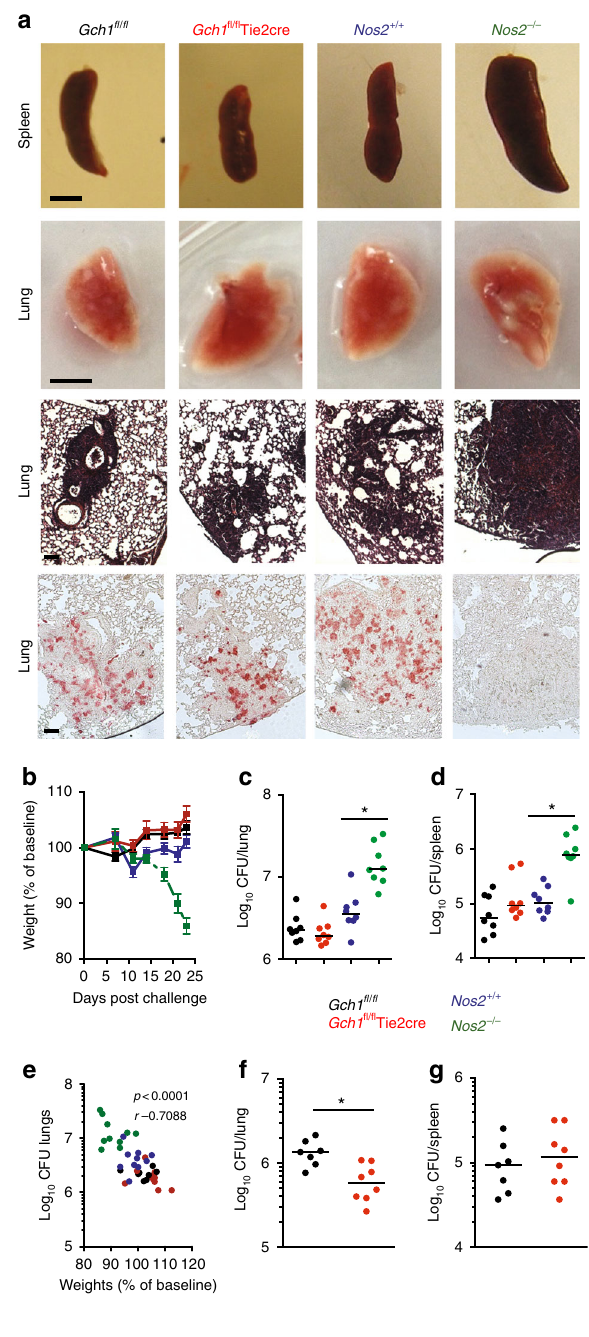
Fig. 3 Absence of Gch1 increases resistance of mice to virulent M.tb infection. Gch1 fl / fl Tie2cre (red) and wildtype (black), Nos2 − / − (green) and Nos2 + / + (blue) mice were infected with 150 CFU M.tb (Erdman strain) by aerosol inhalation. 23 days following infection the lungs and spleen were removed for analysis. Representative organs were imaged from each genotype prior to n = 2 tissues per genotype being embedded for histochemical analysis. Sections were cut from all tissues and stained with H&E or subjected to anti-iNOS immunohistochemistry ( a ). Animals were weighed at regular intervals throughout the experiment and the mean weight change and SEM per group was plotted ( b ). Lungs and spleen were homogenised and the mycobacterial load of the organs was enumerated by CFU count from lung ( c ) and spleen ( d ) ( n = 8 per group, * p < 0.01) (Mann – Whitney). Each dot represents one mouse, line in each group represents the median CFU. e Weights negatively correlated with CFU counts. Pearson r p < 0.05. f Gch1 fl / fl Tie2cre (red) and Gch1 fl / fl (black) mice were infected as before but this time lungs and spleen were removed 6 weeks following infection for analysis. Lungs and spleen were homogenised and the mycobacterial load of the organs was enumerated by CFU count from lung ( f ) and spleen ( g ) n = 7 Gch1 fl / fl , n = 8 Gch1 fl / fl Tie2cre, * p < 0.01 (Mann – Whitney). The fi nding in ( f ) was replicated on two occasions in independent experiments. Scale bars: upper panels 0.5